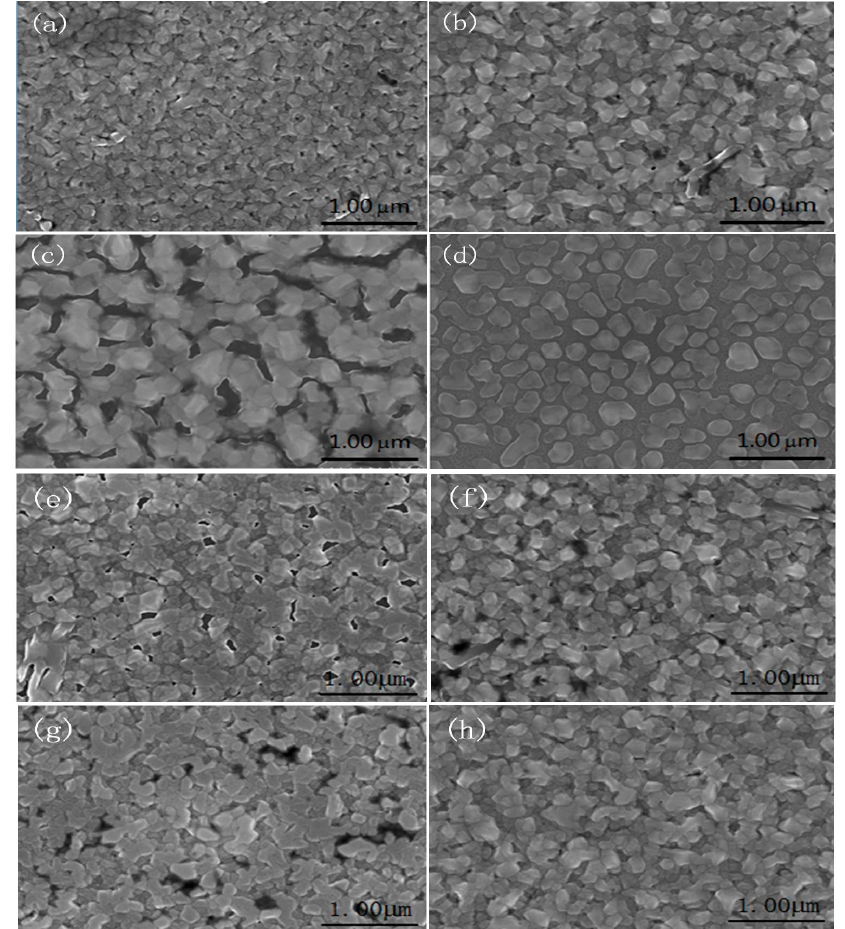
Figure 3. Representative Field Emission Scanning Electron Microscopy (FE-SEM) images of VO 2 /6H-SiC films, ( a – d ) corresponds to SEM images from S 1 - 1 to S 1 - 4 ; and SEM images displayed by ( e – h ) were sequentially assigned to the samples in the S 2 group with deposition time of 10 min, 30 min, 50 min, and 70 min.